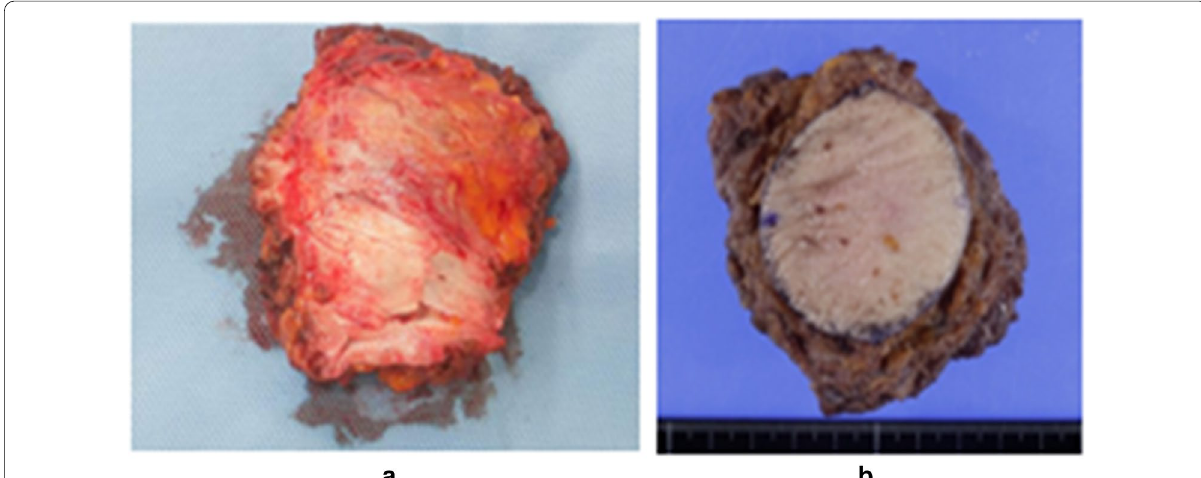
Fig. 3 Macroscopic findings of the resected tumor ( a ). Excised specimen ( b ). Well circumscribed solid lesion approximately 40 mm in maximum diameter